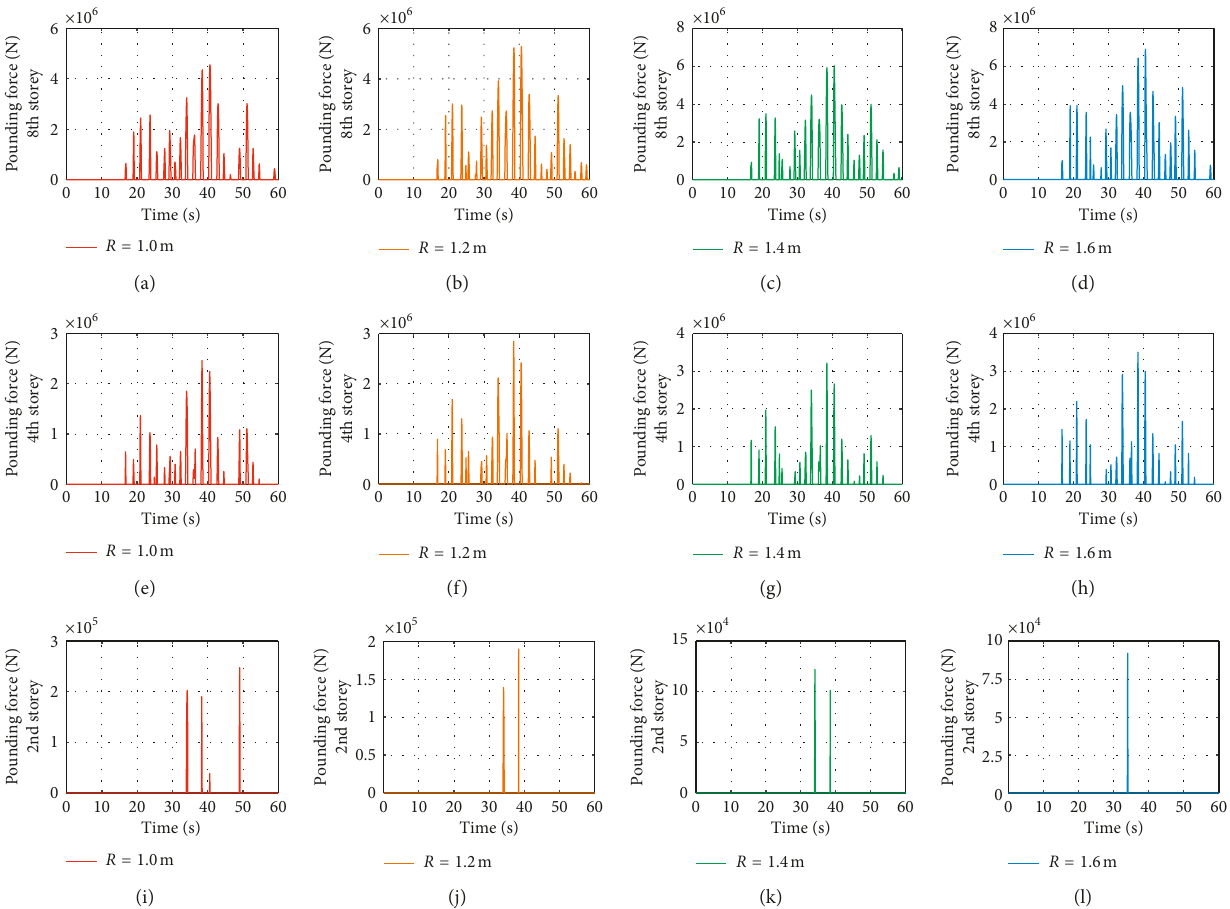
Figure 9: Pounding force influenced by parameters of C material; (c) Type C material; (d) Type D